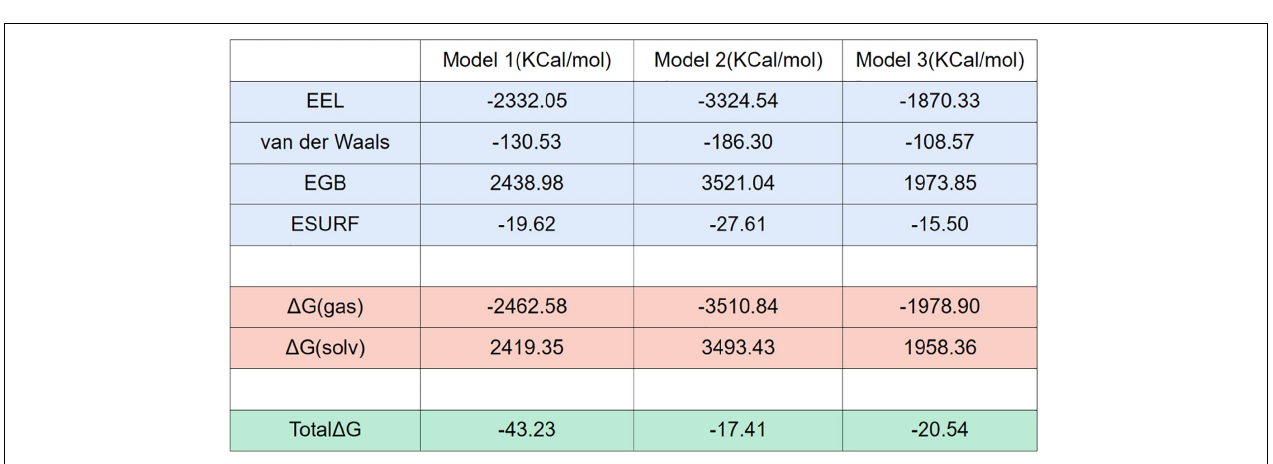
FIGURE 7 | Free energy calculations and decompositions for each model. All units are in KCal/mol.